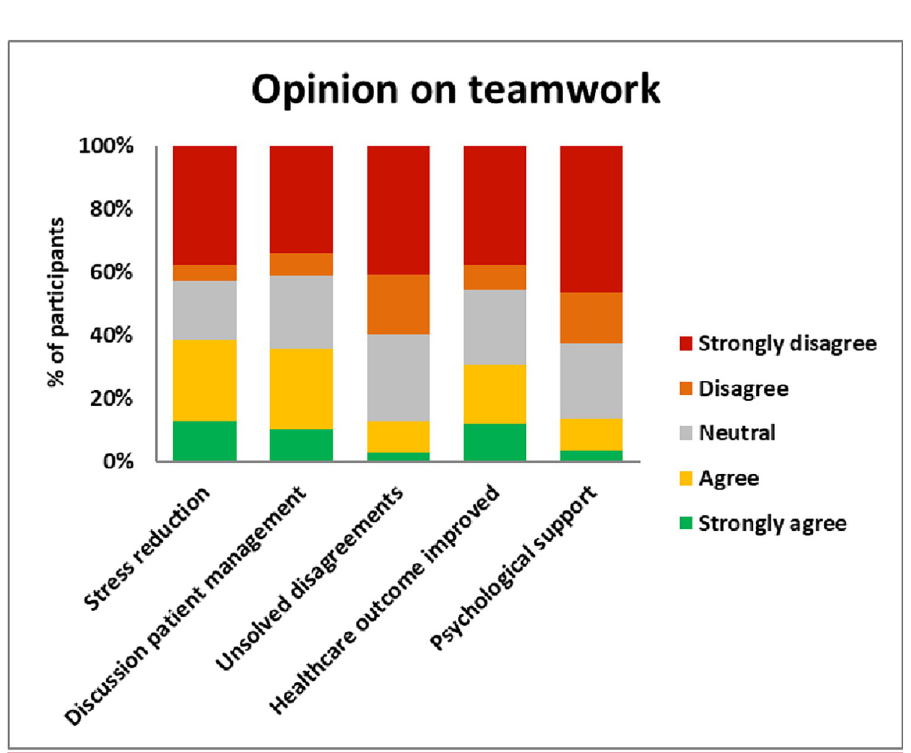
Fig 1. Opinions on interprofessional teamwork during the pandemic among healthcare